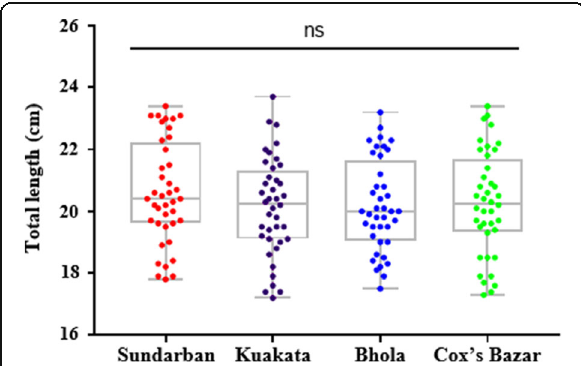
Fig. 3 Size frequency distribution of sardine, Amblygaster clupoides , in four different stocks